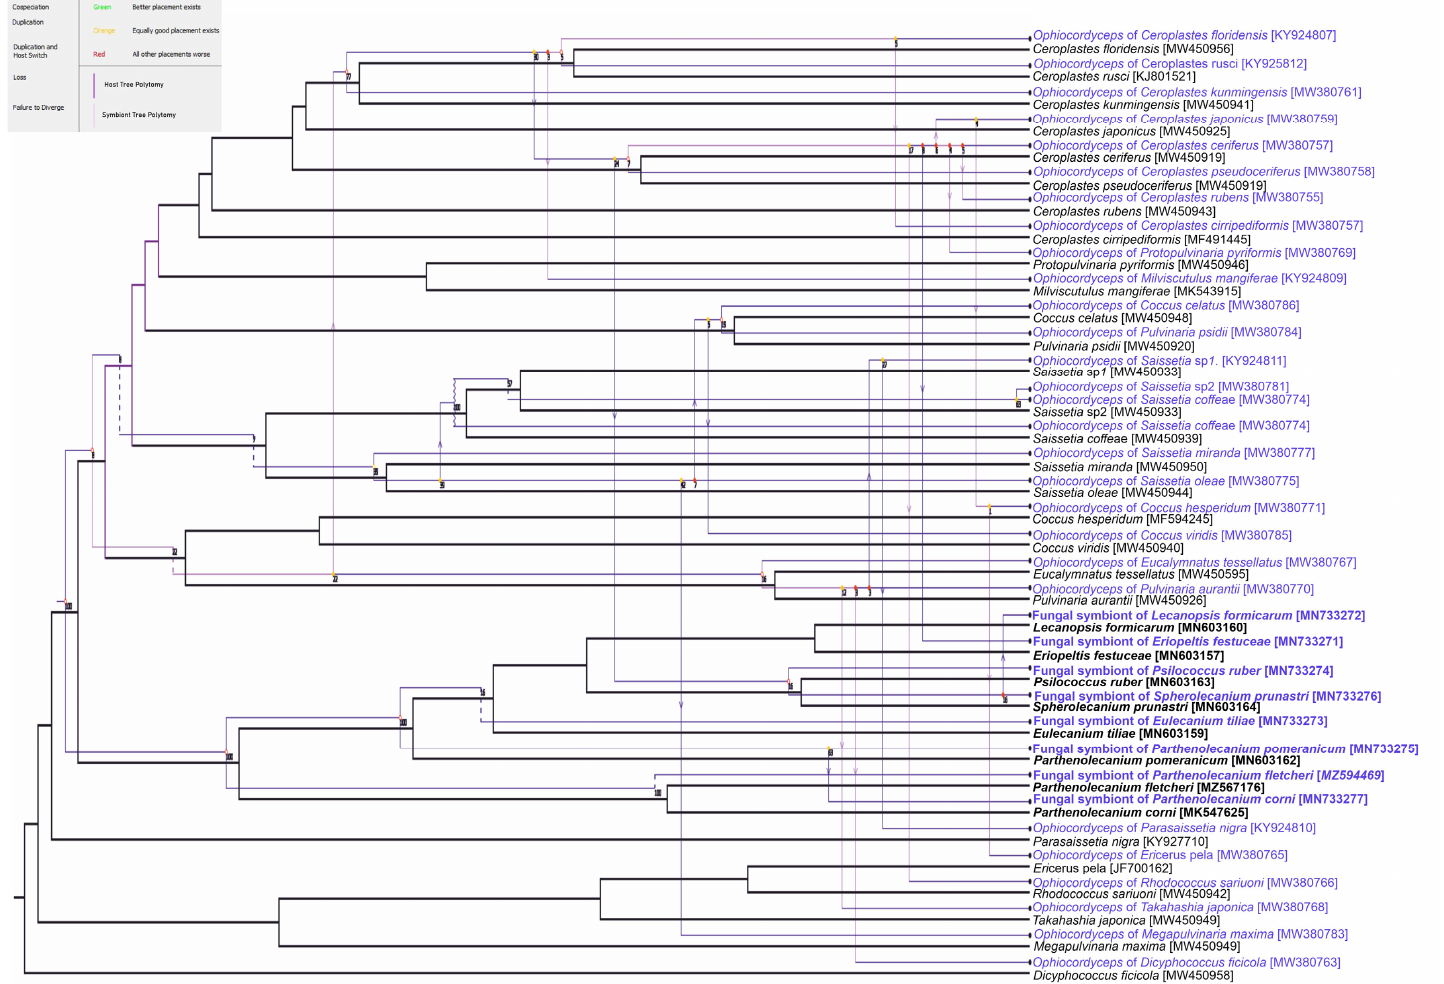
Figure 2. Co-phylogenetic analysis between the Ophiocordyceps symbionts’ tree and their host’s tree (constructed on the base of the ITS2 genes of fungal symbionts and COI genes of host scale insects). Black and blue lines indicate the phylogenies of the scale insects and Ophiocordyceps, respectively. Hollow red circles indicate co-speciation events, solid red and yellow circles indicate duplications, arrows indicate host events, dashed lines indicate losses, and uneven lines indicate failures to